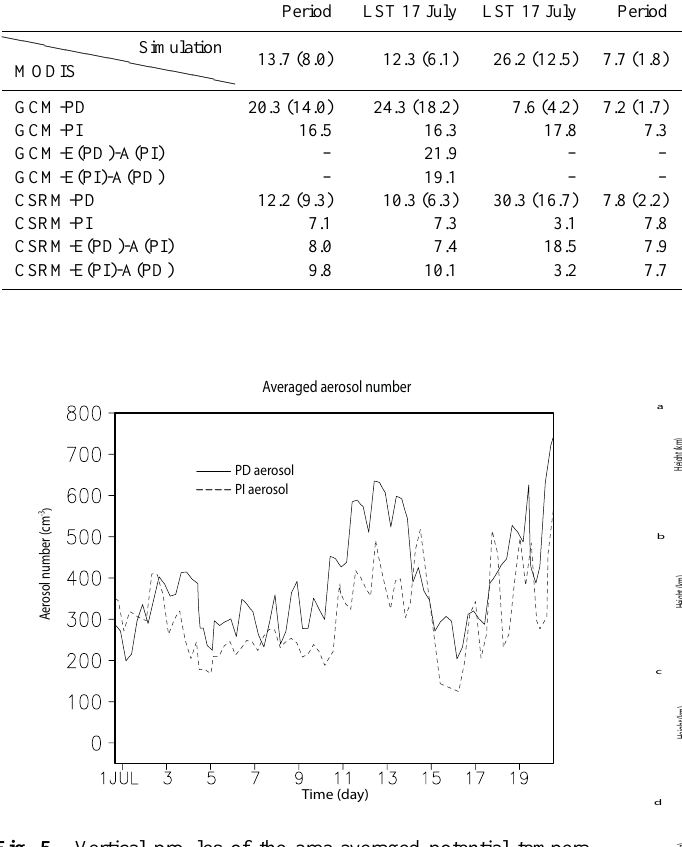
Fig. 5. Vertical profiles of the area-averaged potential tempera- ture and water-vapor mixing ratio at (a) 00:00LST on 11 July, (b) 00:00LST on 15 July, and (c) 16:00LST on 20 July for CSRM- and GCM-PD runs.